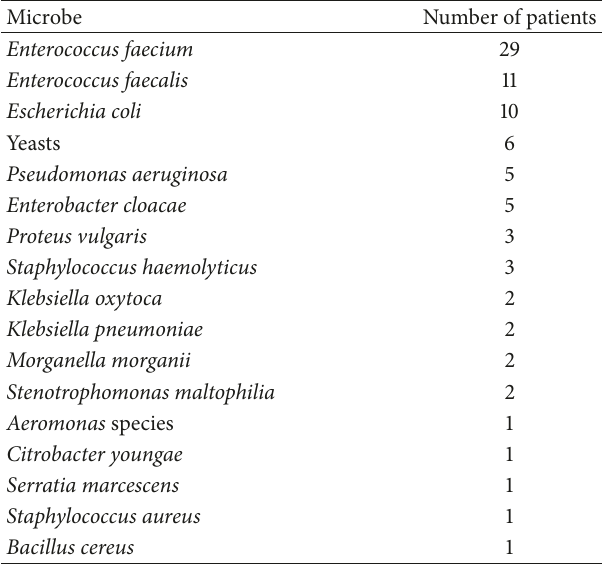
Table 4: The results of microbial culturing from peritoneal fluid during VAC